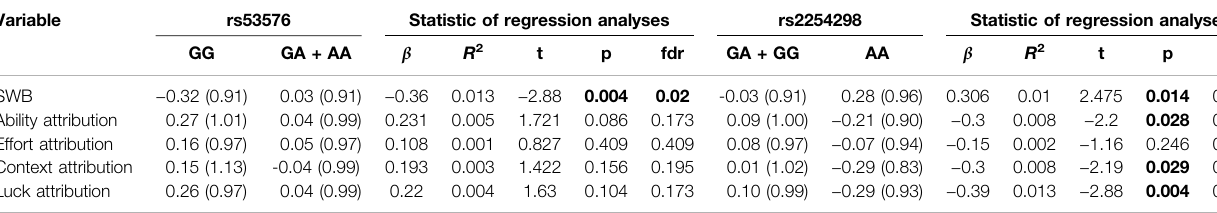
TABLE 3 | Regression analyses on the impacts of OXTR SNPs on af fi liation attributional styles Variable